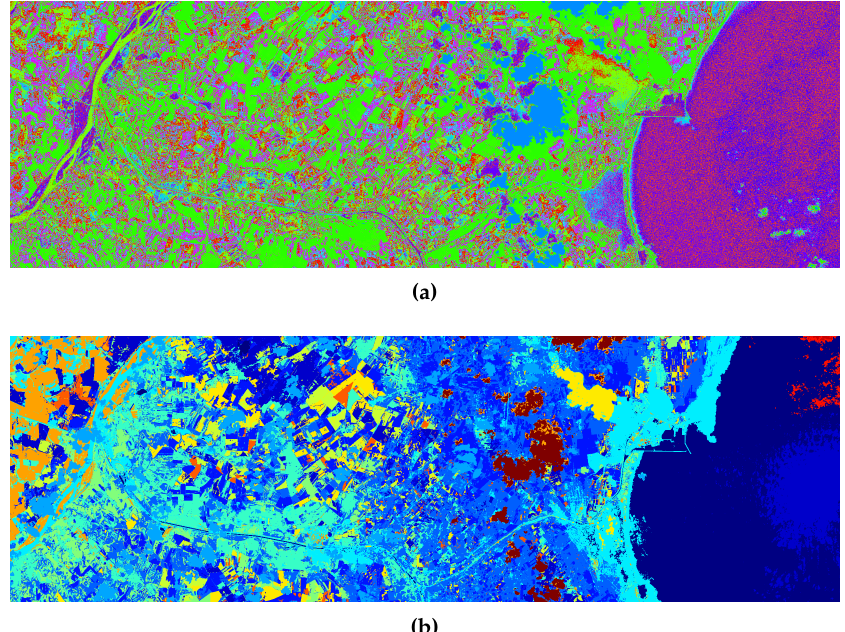
Figure 14. Analysis of Dobrogea SITS: ( a ) DTW-based K-means clustering [7], ( b ) Latent Dirichlet Allocation (LDA)-based clustering